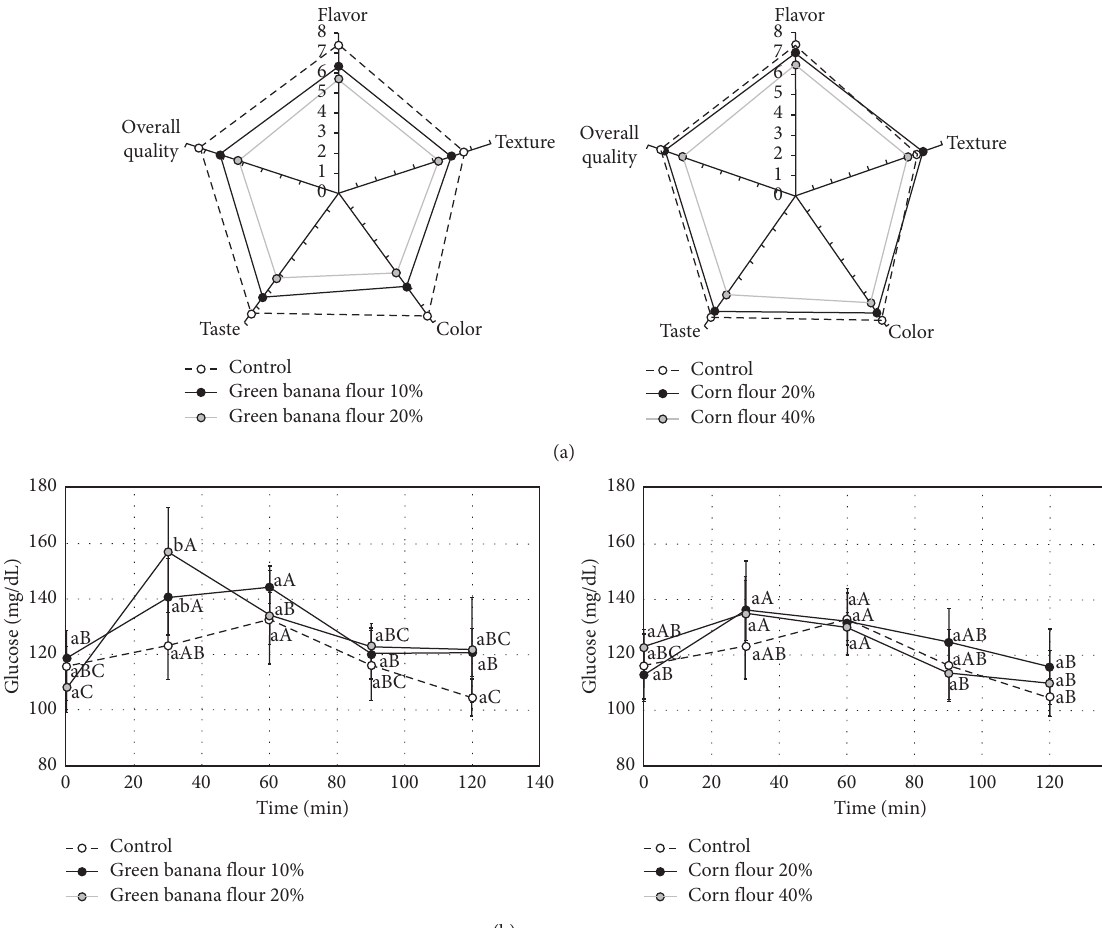
Figure 3: (a) In average sensorial analyses, the data are expressed as the mean of testers ( n � 115) of the different bread samples. (b) Blood glucose levels after oral administration of bread samples in rats expressed as mean ± standard deviation ( n � 5): (1) green banana (GF)- wheat flour breads and (2) corn (CF)-wheat flour breads. ∗ Different lowercase letters indicate statistical difference between the different groups for the same digestion time. ∗∗ Different capital letters indicate statistical difference between the different digestion times for the same group. ∗∗∗ Control group is the same for all in vivo experiments. Control � bread produced with only wheat flour + baking improver concentration of 1 g/100 g of flour; corn flour 20% � bread produced with corn flour concentration of 20 g/100 g + baking improver concentration of 1 g/100 g of flour; corn flour 40% � bread produced with corn flour concentration of 40 g/100 g + baking improver concentration of 1 g/100 g of flour; green banana flour 10% � bread produced with green banana flour concentration of 10 g/100 g + baking improver concentration of 1 g/100 g of flour; and green banana flour 20% � bread produced with green banana flour concentration of 20 g/100 g + baking improver concentration of 1 g/100 g of